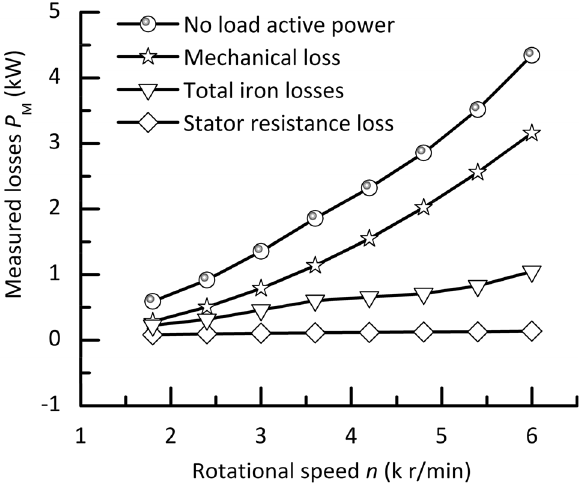
Figure 6. Experimental curves of various losses of the prototype under no load.